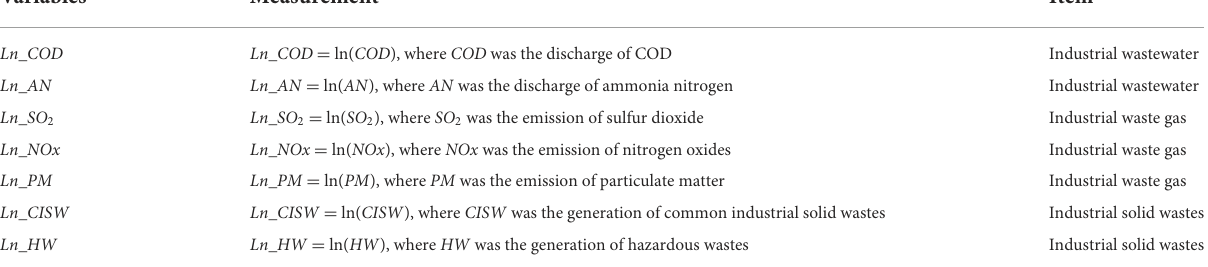
TABLE 1 Dependent variables in empirical